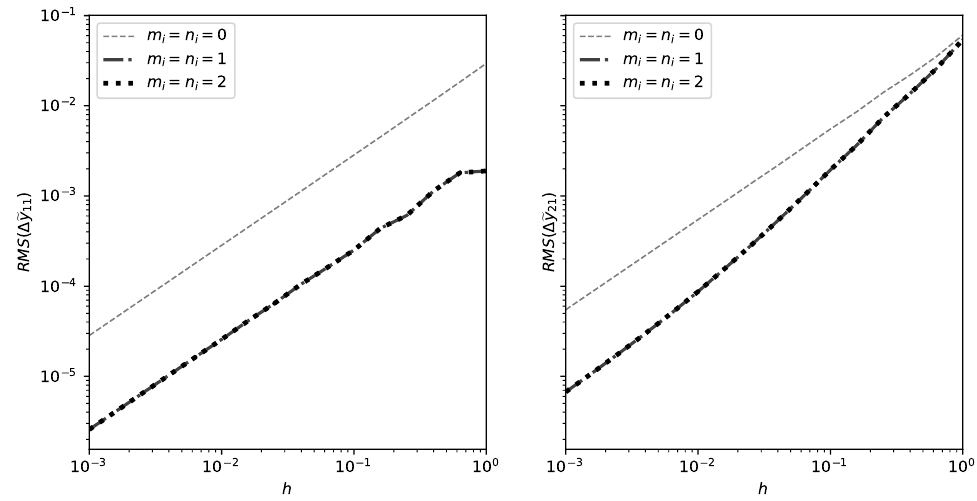
Figure 6. The diagrams show the numerical errors of the fixed-step Jacobi co-simulation method (Algorithm 1, H [ k ] = H [ k − 1 ] = H 1 ), different orders of interpolation polynomials and different internal subsystem